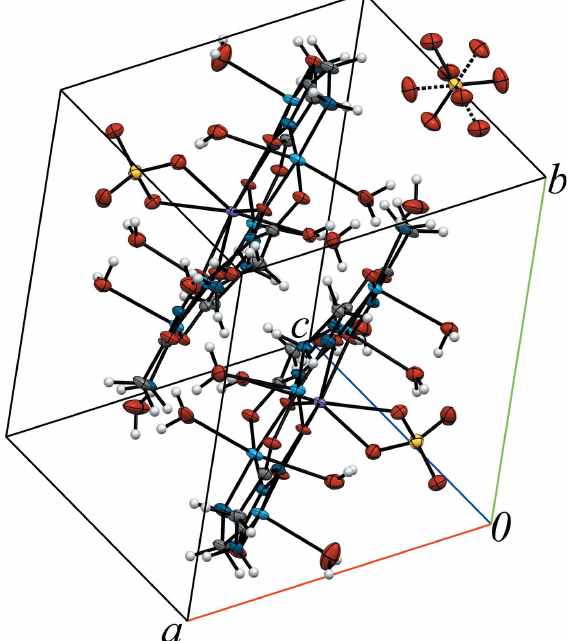
Figure 1 The unit cell of complex 1 containing two [TbCu 5 (GlyHA) 5 - (SO 4 )(H 2 O) 6.5 ] + metallacrown cations and non-coordinated sulfate anions (located on a inversion center with O atoms 1:1 disordered). Non-coordinated water molecules are omitted for clarity of presentation.